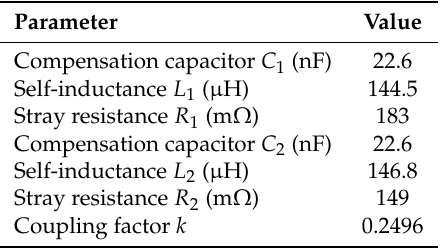
Table 3. Parameters of the SS compensation